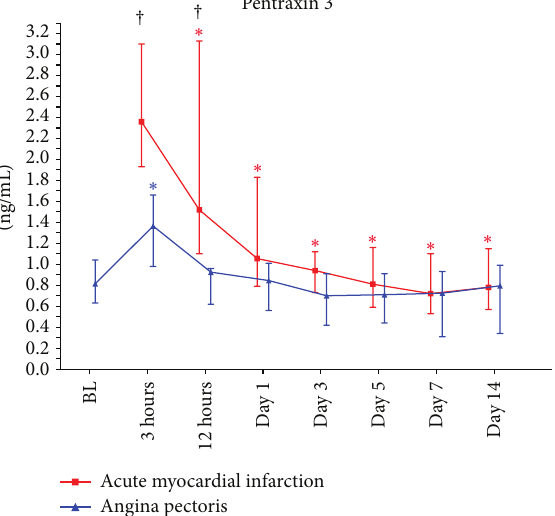
Figure 1: The time profile of circulating PTX3 levels. BL: baseline; † 𝑃 < 0.05 for between-group differences at the various time points; ∗ 𝑃 < 0.05 for intragroup differences from baseline in the angina pectoris group and from time point 3 hours in the acute myocardial infraction